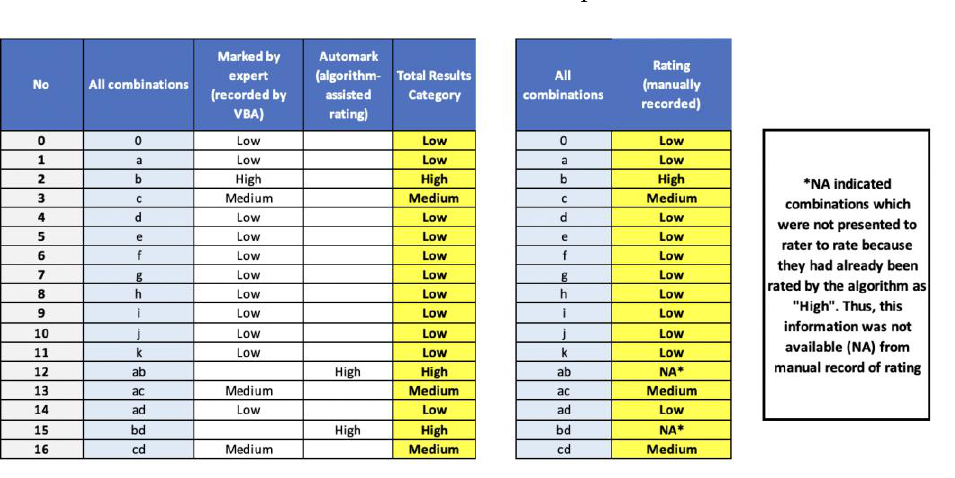
Figure 7. Validation of a section of the dashboard-based rating via comparison and inspection with the manual record.